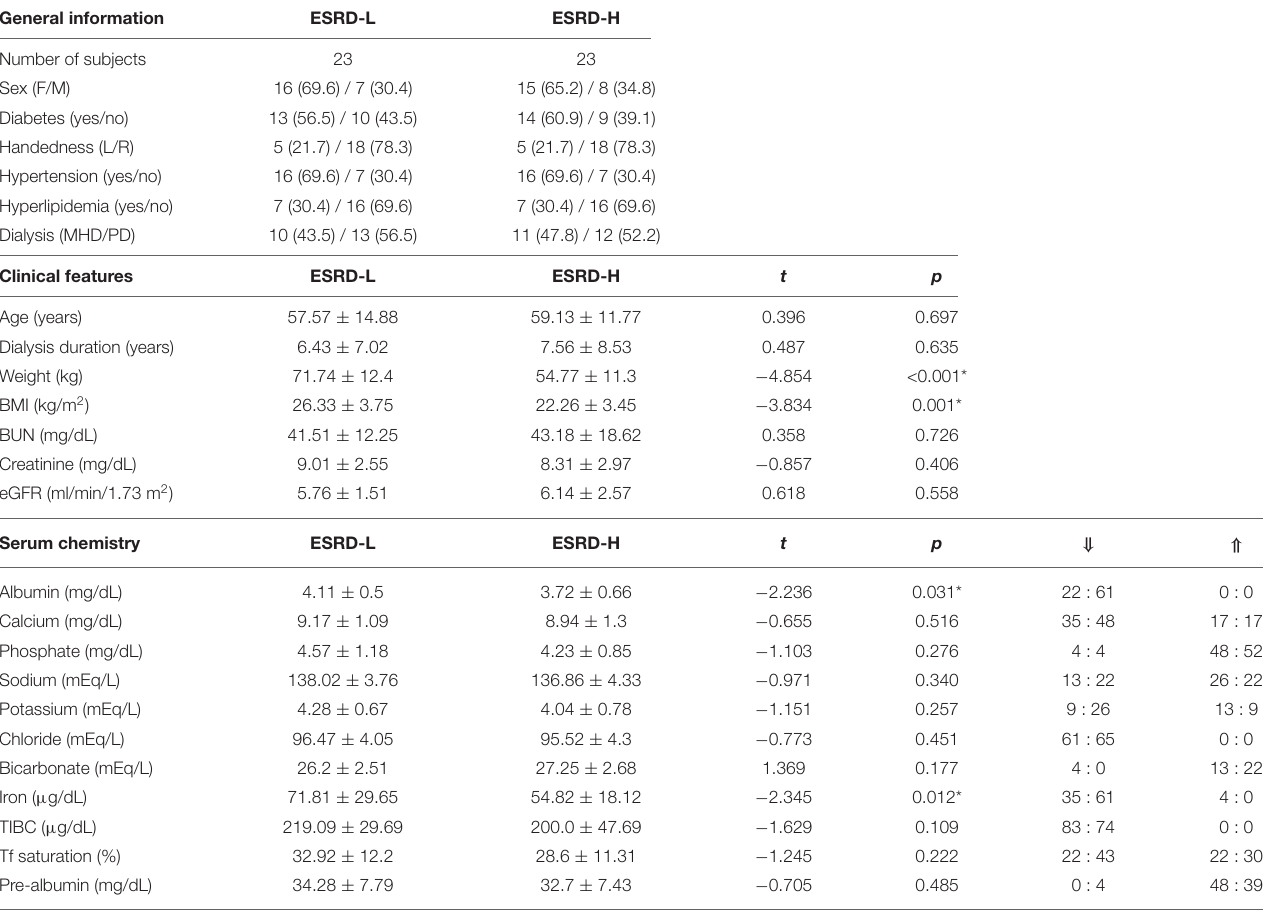
TABLE 1 | The demographic information of 46 subjects shows that the weight and BMI of ESRD-L patients were significantly higher than those of ESRD-H patients ( ∗ p ≤ 0.001), while other parameters were not different between groups, as compared by the permutation-based t -test. General